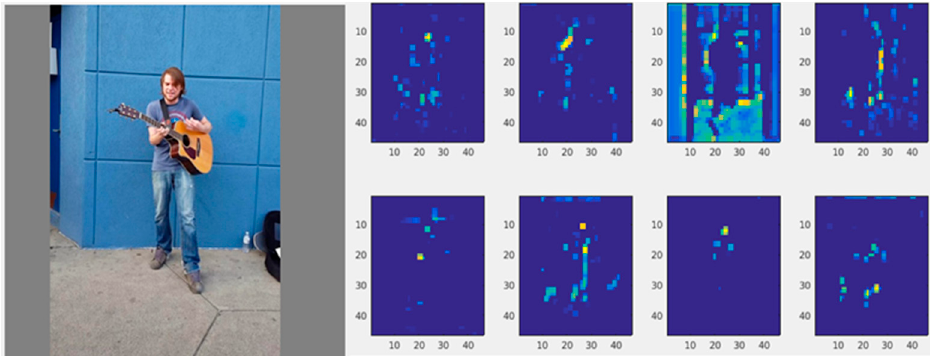
Figure 3. The original color image and some feature maps with a depth of 128.